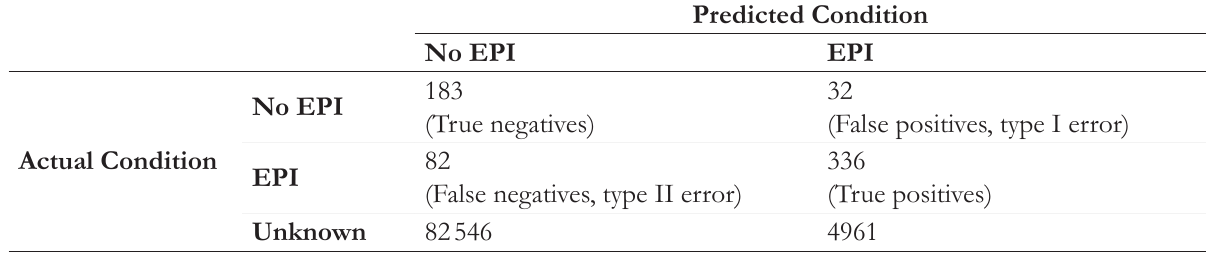
Table 4. Confusion Matrix of Model